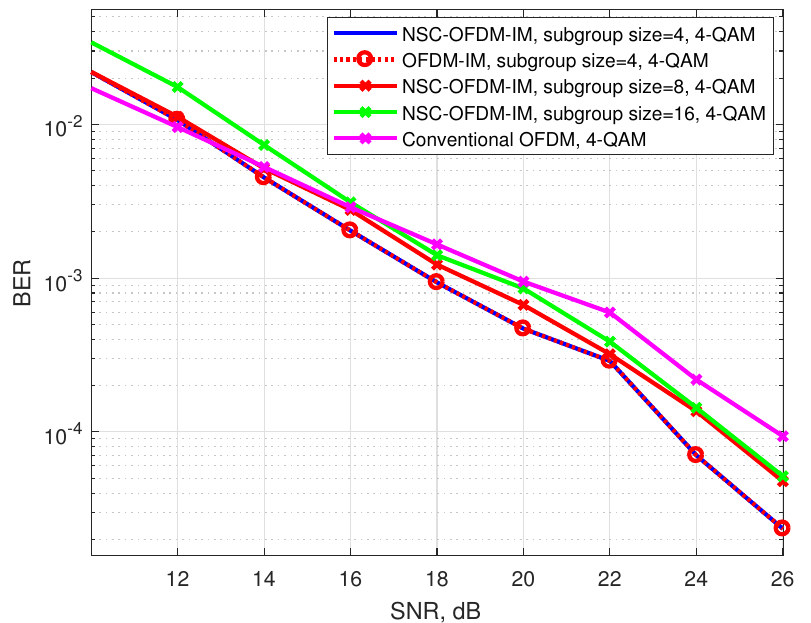
Figure 10. BER performance comparison between the proposed NSC-OFDM-IM and conventional OFDM-IM/OFDM, where 4-QAM modulation was